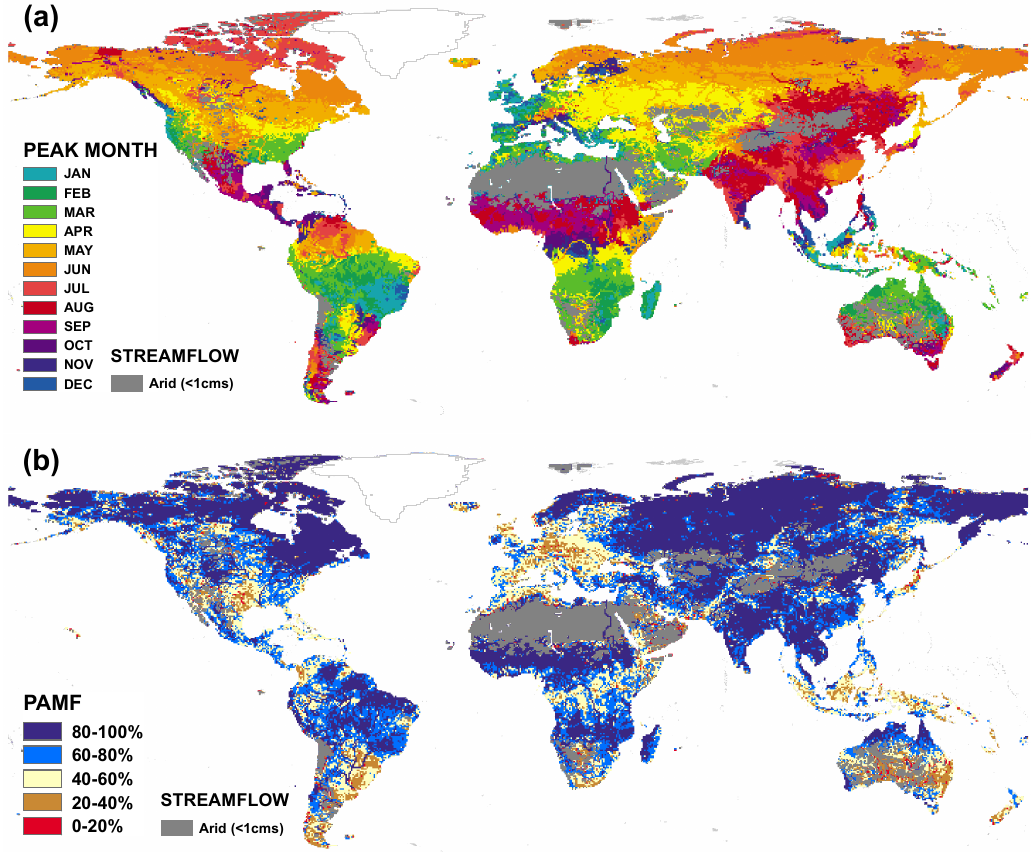
Figure 8. (a) Peak month (PM) as defined at all modeled grid cells and (b) calculated percentage of annual maximum flow (PAMF) values for all modeled grid cells, subjectively classified as high (80–100%), moderate (60–80%), low (40–60%) and poor